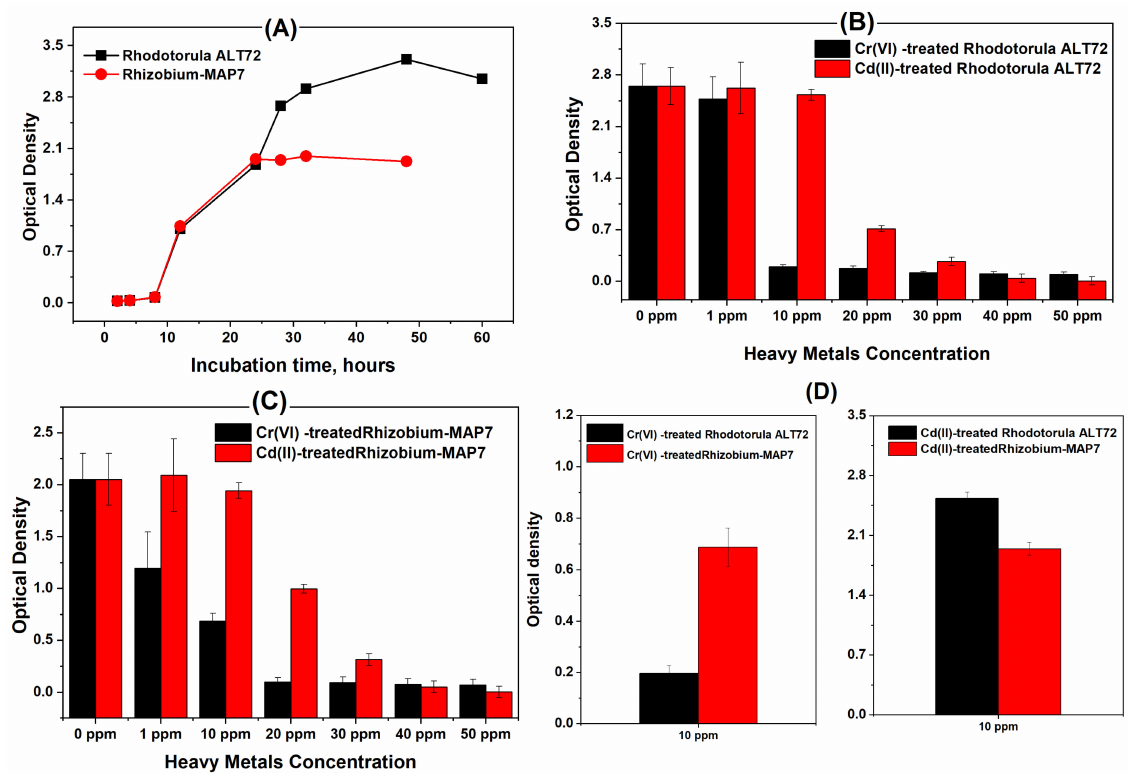
Figure 1. ( A ) Typical growth curves of untreated cells of Rhodotorula ALT72 and Rhizobium -MAP7, ( B ) effect of metal ions concentrations on the growth inhibition of Rhodotorula ALT72, ( C ) sensitivity of Rhizobium -MAP7 to Cr(VI) and Cd(II) different concentrations and ( D ) responses of Rhodotorula ALT72 and Rhizobium -MAP7 to a single concentration of Cr(VI) and Cd(II). The results recorded after 48 h for the Rhizobium -MAP7 and 60 h for the Rhodotorula ALT72. Table 1. Measuring the remaining concentrations of metal ions in the microbial supernatants after culturing the Rhodotorula ALT72 and Rhizobium -MAP7 in synthetic contaminated liquid media. Metal ions concentrations were detected by Atomic Absorption Spectroscopy. Heavy Metals Conc. Rhodotorula sp. Rhizobium